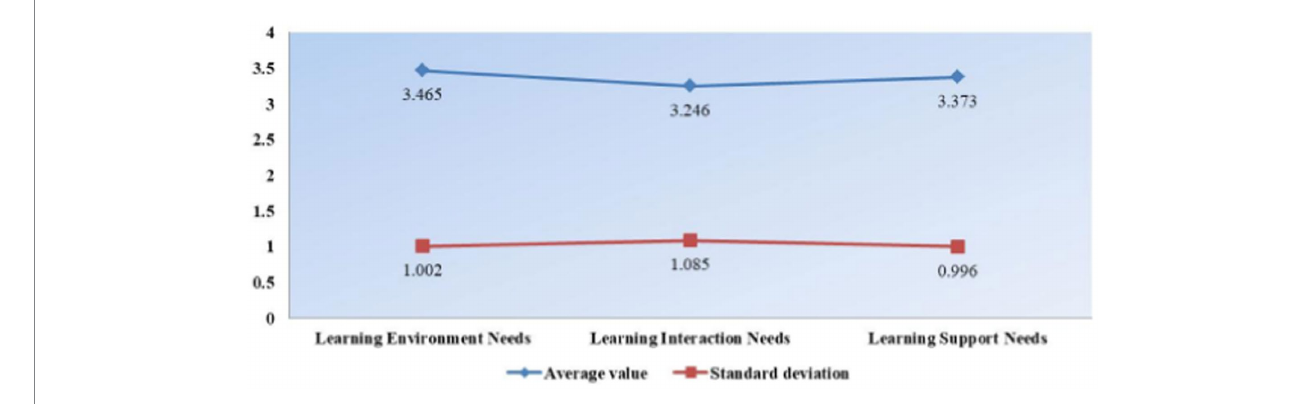
FIGURE 1 Statistical linear plot of learning needs.